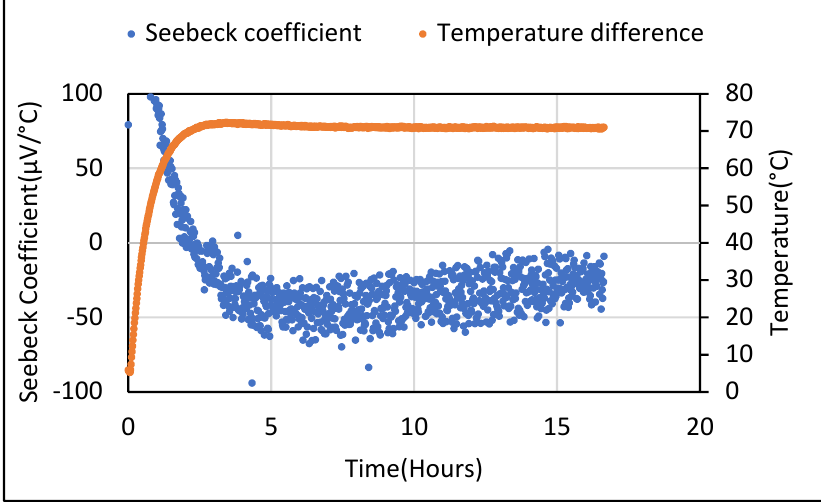
Figure 13. Seebeck coefficient obtained from dried 5 wt.% Bi 2 O 3